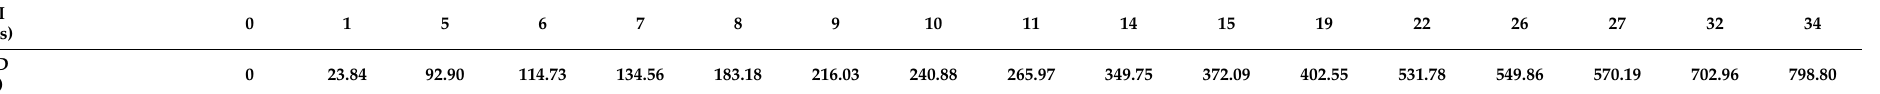
Table 3. Mutations that were found only during specific PMIs.